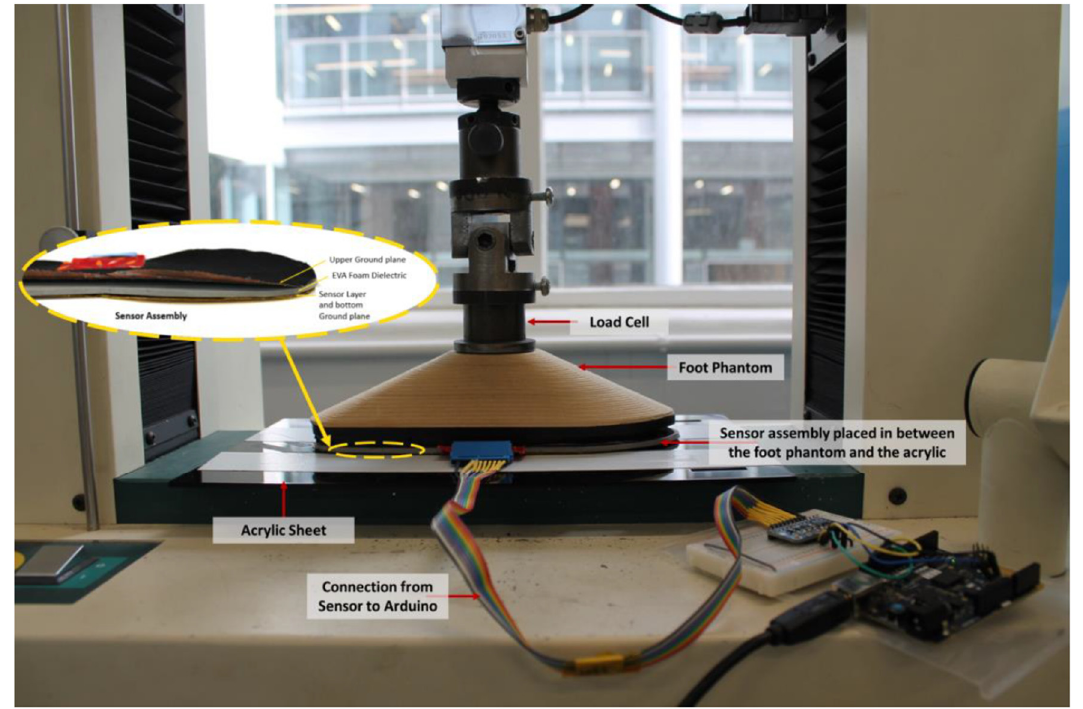
Figure 11. Test Setup for Tests 1 and 2.